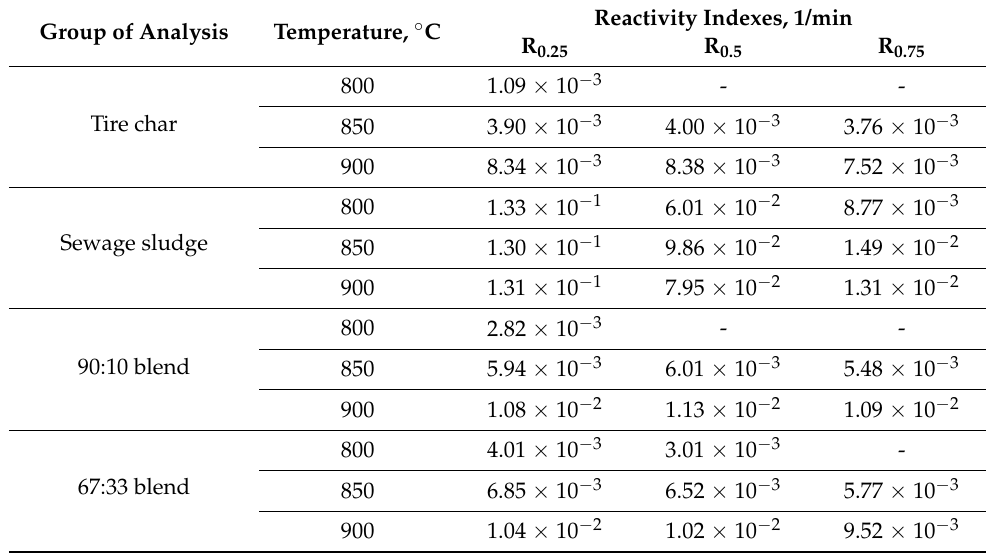
Table 2. Reactivity indexes R x during steam